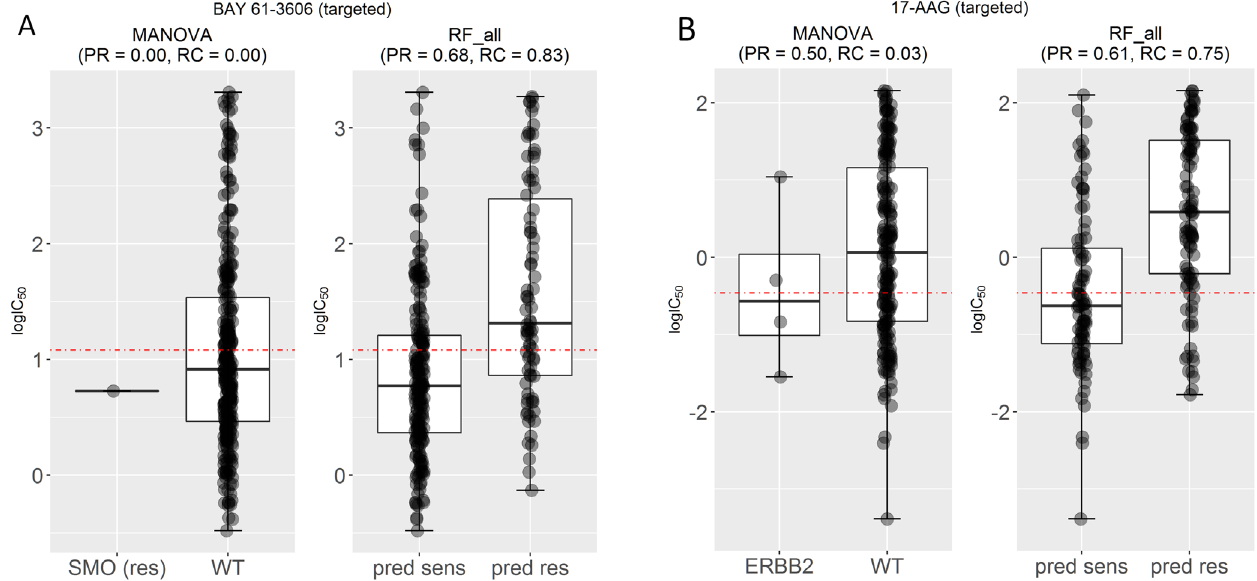
Figure 5. Examples of drugs that have high recall and F-scores. ( A ) Mutated Smoothened, Frizzled Class Receptor (SMO) was the most significant single-gene marker for BAY-61-3606 resistance (P=0.03) using training data. On the test set, this marker obtained no precision and no recall because the only SMO-mutant test set cell line was misclassified. By contrast, the corresponding multi-gene marker, built with the same training data, obtained a high precision (PR=0.68) and better recall (RC=0.83) on the same test data. ( B ) Mutated receptor tyrosine-protein kinase erbB-2 (ERBB2) is the most significant single-gene marker of 17-AAG sensitivity (P=0.008), but its test set recall is poor (RC=0.03). By contrast, the multi-gene marker achieves a much higher precision (PR=0.61) and recall (RC=0.75).